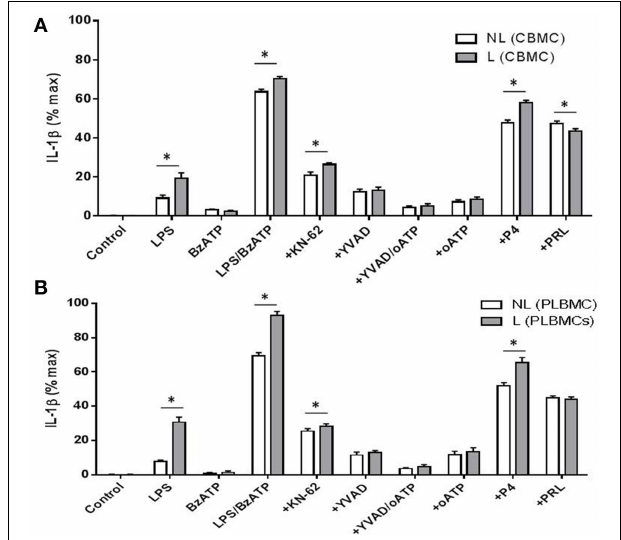
FIGURE 5 | CBMCS and PLBMCs from laboring (L) and non-laboring (NL) women incubated with LPS and BzATP leads to increased IL-1 β release. Costimulation with LPS and BzATP led to increased release of IL-1 β than either LPS or BzATP alone from (A) CBMCs and (B) PLBMCs. Cells from laboring women produced significantly greater amounts of IL-1 β . IL-1 β release was inhibited following preincubation with the P2X 7 antagonists KN-62, oATP and the caspase -1 inhibitor YVAD-CHO following costimulation with LPS and BzATP as indicated on graphs by a “ + ” prefix before treatment. A combination of YVAD and oATP led to greater inhibition of IL-1 β than either inhibitors alone, Both LPS and BzATP_evoked IL-1 β release which was inhibited by P4 and prolactin in (A) CBMCs and (B) PLBMCs. ( * P < 0 . 05